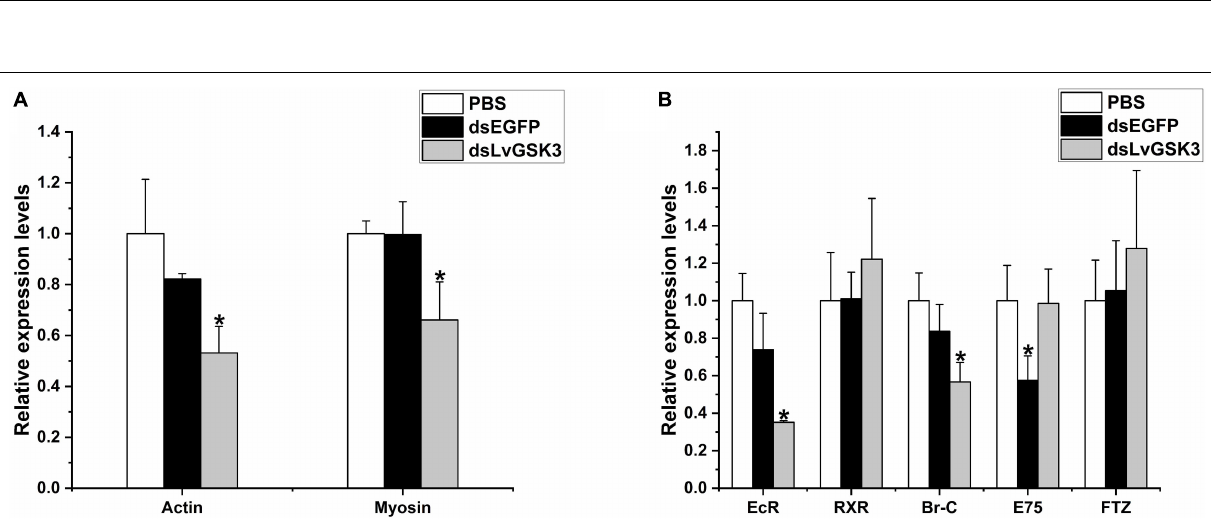
FIGURE 8 | The expression level of growth- and molting-related genes in LvGSK3 RNAi samples. (A) The relative expression level of growth-related genes. (B) The relative expression level of molting-related genes. The results were based on three independent biological replications and showed at mean values ± SD. Significant differences of the gene expression levels between three treatments are shown as * p <